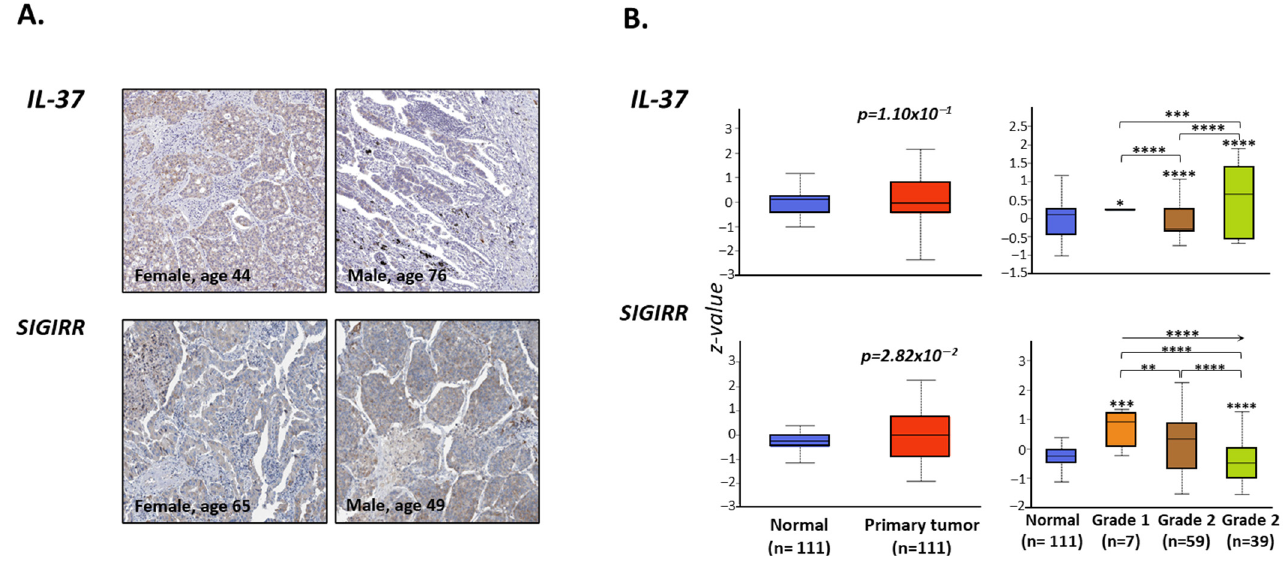
Figure 4. ( A ) Immunohistochemical staining of IL-37 and SIGIRR proteins in lung biopsies of LUAD patients. Pictures were obtained from www.proteinatlas.org [35] (accessed on 20 September 2022). ( B ) Box and Tukey whiskers diagrams depicting the differential protein expression levels of IL-37 and SIGIRR (z-values) in LUAD primary tumors (n = 111) vs. normal tissues (n = 111) and among LUAD tumors of different grade (1 to 3). Figures and graphs were exported from http: //ualcan.path.uab.edu/ [33] (accessed on 20 September 2022). *: p < 0.05, **: p < 0.01, ***: p < 0.001, ****: p <